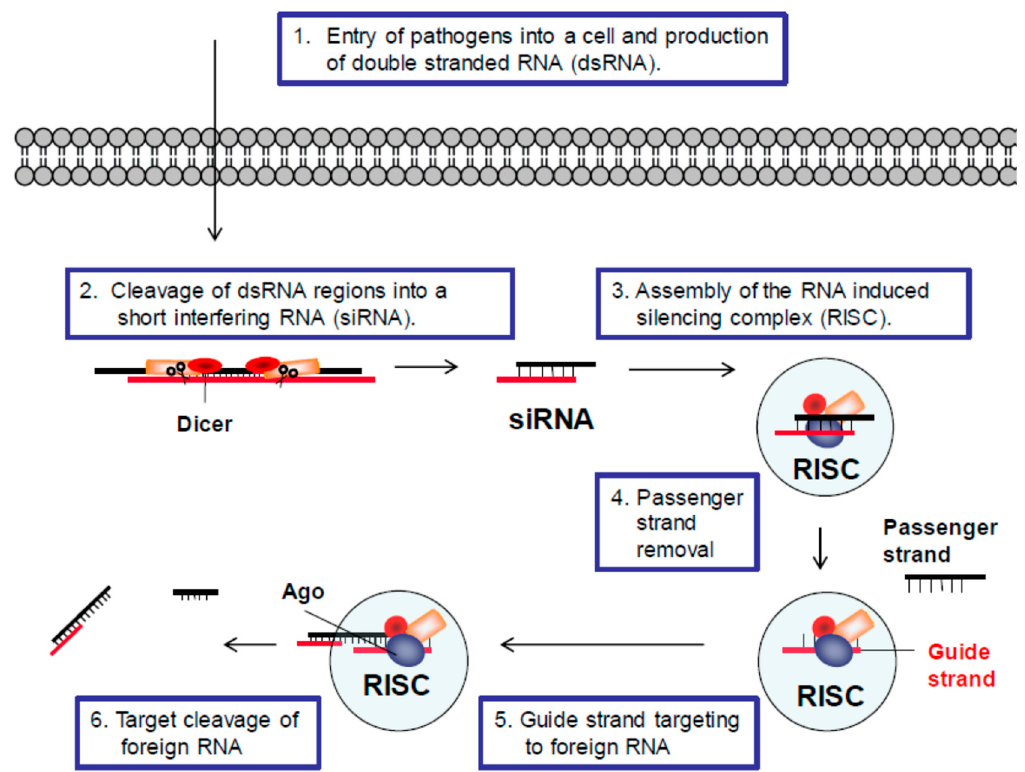
Figure 1. RNA interference (RNAi) defense pathway. The general steps of the RNAi defense pathway are illustrated: (1) Double stranded RNAs (dsRNA) are produced from pathogens such as viruses, satellite RNAs and retrotransposons. (2) Regions of pathogenic dsRNAs are recognized by a complex including the Dicer enzyme, which processes these regions into small interfering RNAs (siRNA). (3) siRNAs are then loaded into the RNA-induced silencing complex (RISC). (4) The passenger strand is removed from the RISC. (5) The guide strand directs the RISC to its complementary target in the pathogenic RNA. (6) The target sequence is cleaved by an Argonaute (Ago) protein in the RISC.